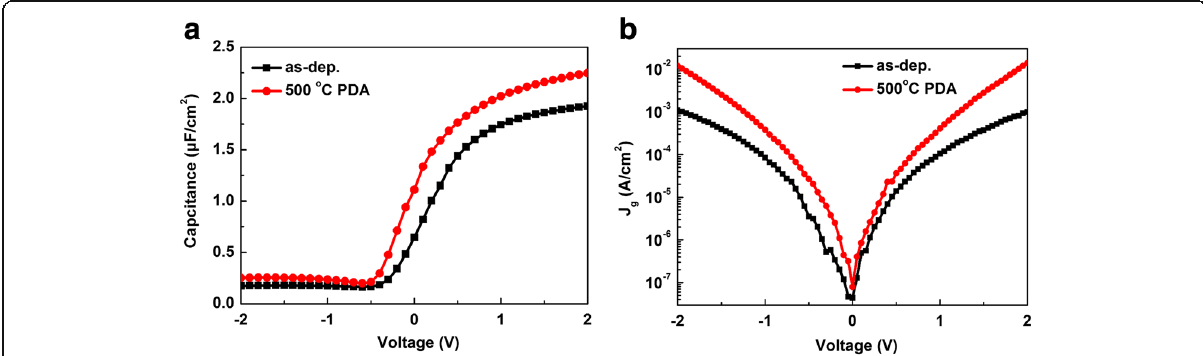
Fig. 2 Electric characteristics of HfO 2 /SiO 2 gate stacks on Ge substrates before and after 500 °C PDA. a High-frequency (1 M Hz) C-V curves. b J-V